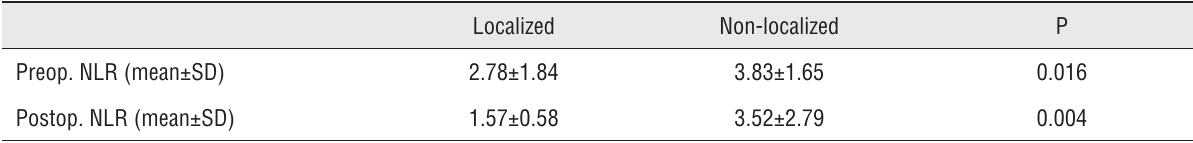
Table 3 - Comparison of neutrophil to lymphocyte ratio between localized and non-localized TGCT. Localized Non-localized